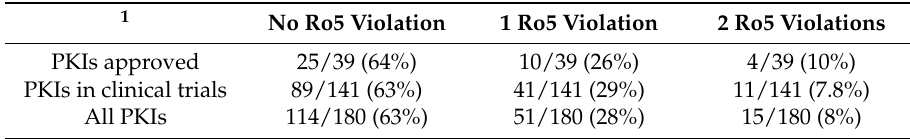
Table A1. Comparison of violation of Lipinski’s rules between approved and in0clinical trial PKIs.